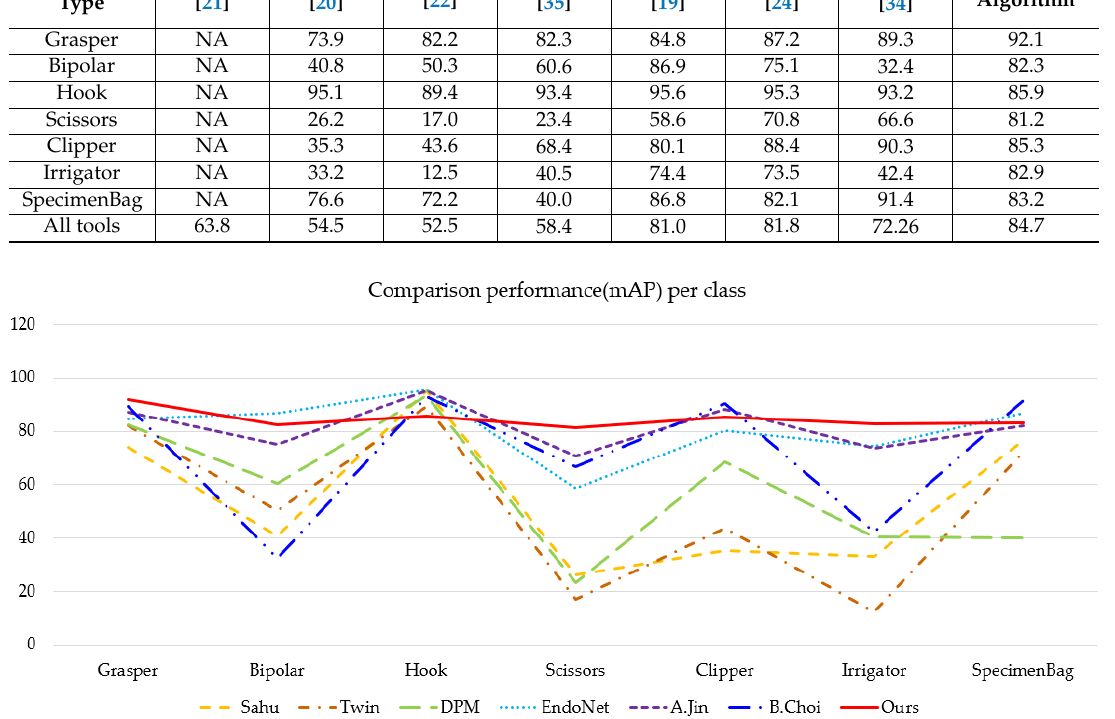
Figure 4. Comparison of mean average precision (mAP) estimates by class for all considered algorithms outlined in Table 2, except the Raju method .